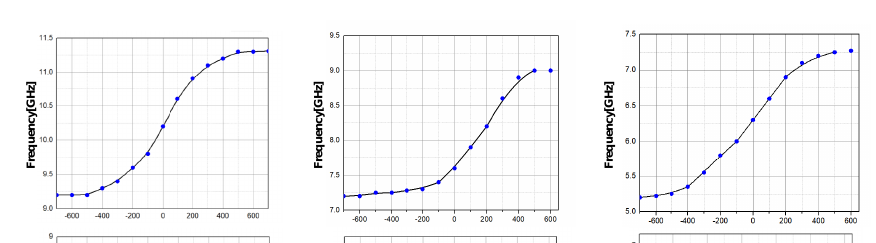
Figure 14. Design of VCO.